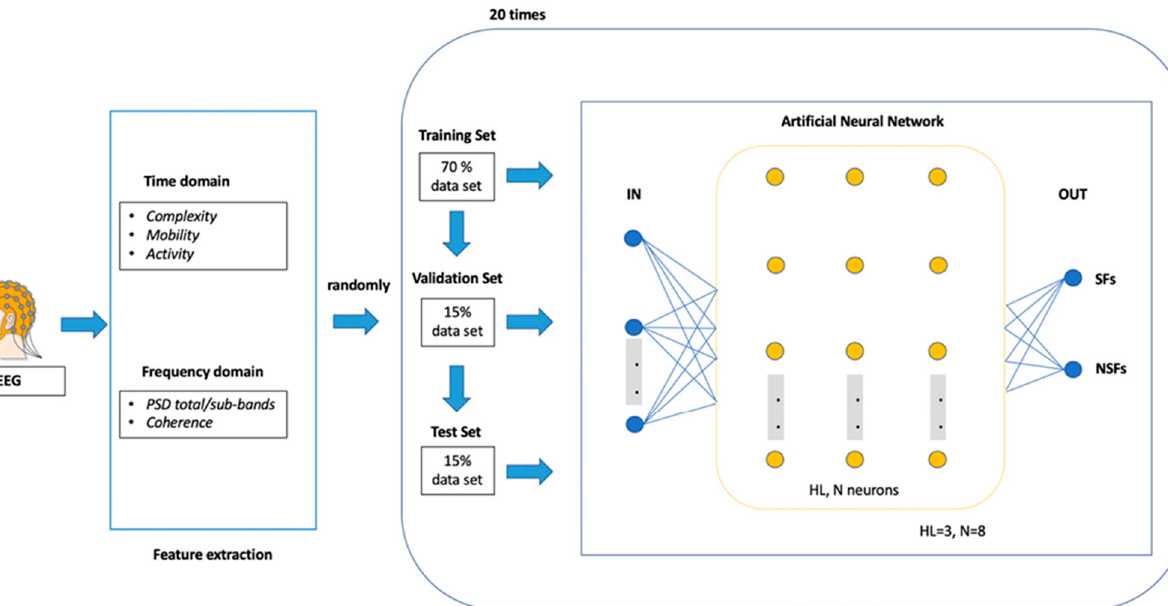
PSD: Power Spectrum Density.